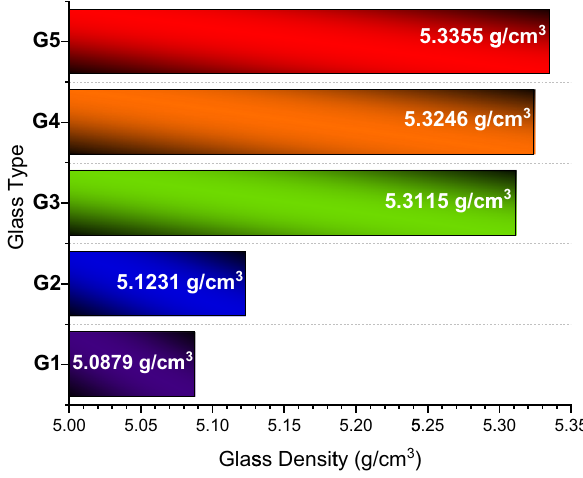
Figure 1: Variation of investigated glass densities.